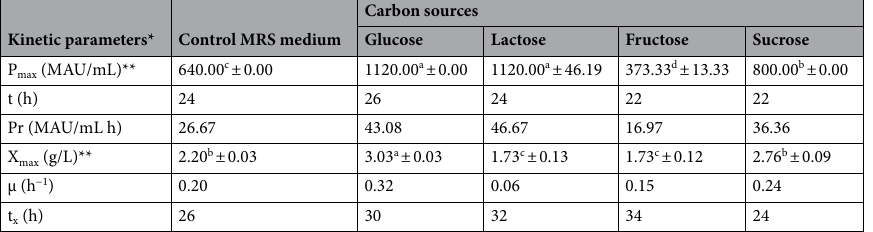
Table 2. Effects of carbon sources on the growth and antimicrobial activity of postbiotic RS5 produced by L. plantarum RS5. *P max (MAU/mL)—maximum antimicrobial activity, t (h)—cultivation time of maximum antimicrobial activity, Pr (MAU/mL h)—productivity of antimicrobial activity, X max (g/L)—maximum biomass, µ (h −1 )—specific growth rate, t x (h)—cultivation time of maximum biomass. **Values for P max (MAU/mL) and X max (g/L) are mean ± standard error of the mean (SEM), n = 3. Mean ± SEM within the same row that does not share a similar superscript are significantly different (p <